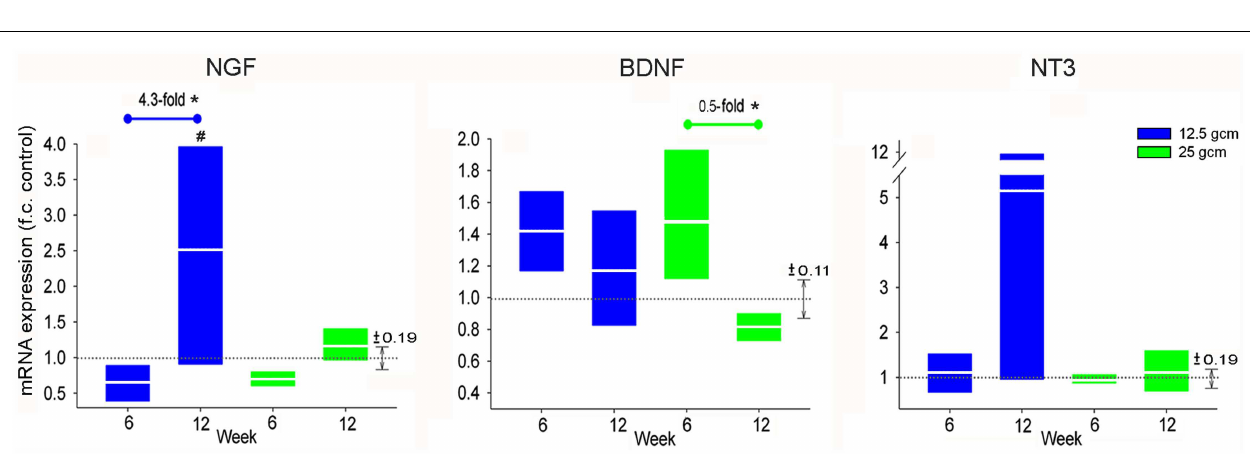
FIGURE 3 | mRNA expression of Neurotrophins is altered in L4/5 DRG at 6 and 12weeks after receiving either 12.5gcm (blue) or 25gcm (green) NYU contusion injury to spinal cord at vertebral levelT9. Fold-change (fc) is reported as change of 12week relative to 6week time points in all figures.